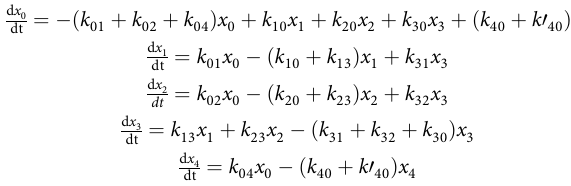
Overall kinetics and comparison with experiments . The Free energies of all reaction intermediates and transition states were calculated as a function of applied potential using our quadratic transformation of the grand canonical potential. Since, the reaction rates depend directly on the applied potential, we obtain the rates from the free energy change to the TS using the Eyring rate equation. Finally, the overall reaction rate and species concentration are calculated using a microkinetic model. The rate equations for each species are as